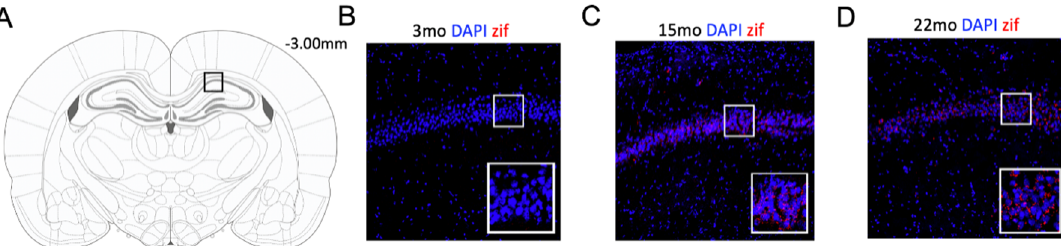
Figure 8. Schematic of coronal section where dorsal hippocampus (DH) slices were taken at − 3.00 mm relative to bregma (Panel A ). Representative images from taken at 20 × 3-month-old (Panel B ), 15-month-old (Panel C ), and 22-month-old (Panel D ) animals have DAPI depicted in blue and zif268 depicted in red. Insets of the highlighted region are shown in the bottom right corner for each image.